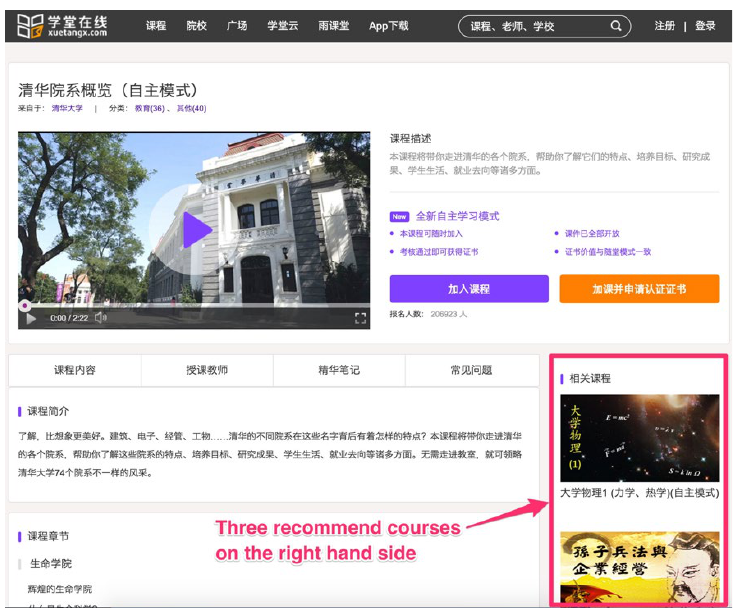
Figure 1 I nterface of a MOOC on